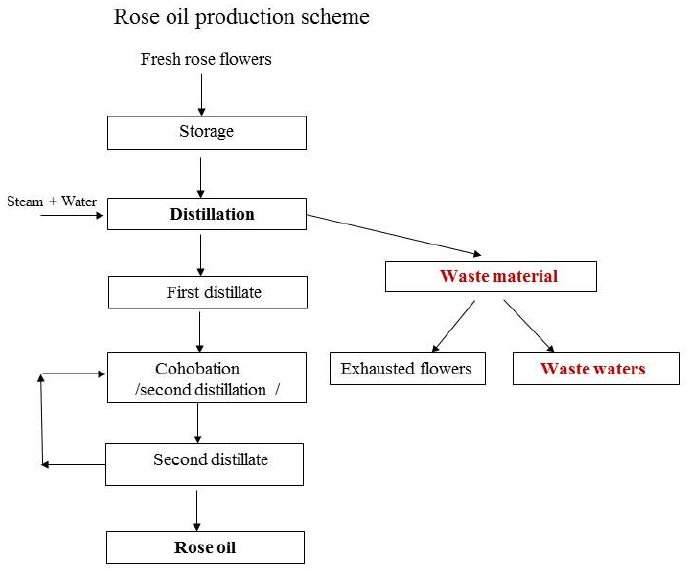
Figure 1. Rose oil production scheme and collection of wastewater material.